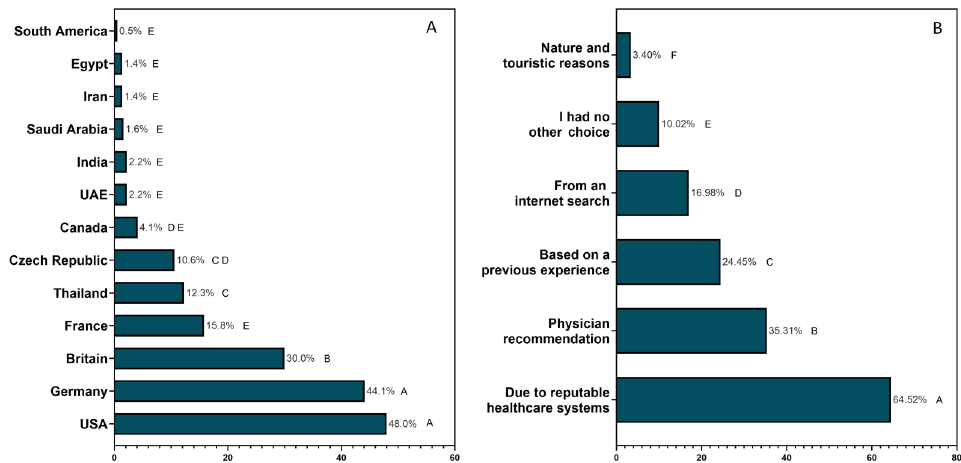
Figure 2 . Preferred Country for Medical Treatment (A, Percentage was calculated from participants that had a specific preference, n=366) and Reasons for Selection of a Country (B, Percentage was calculated from the total number of participants, n=589).